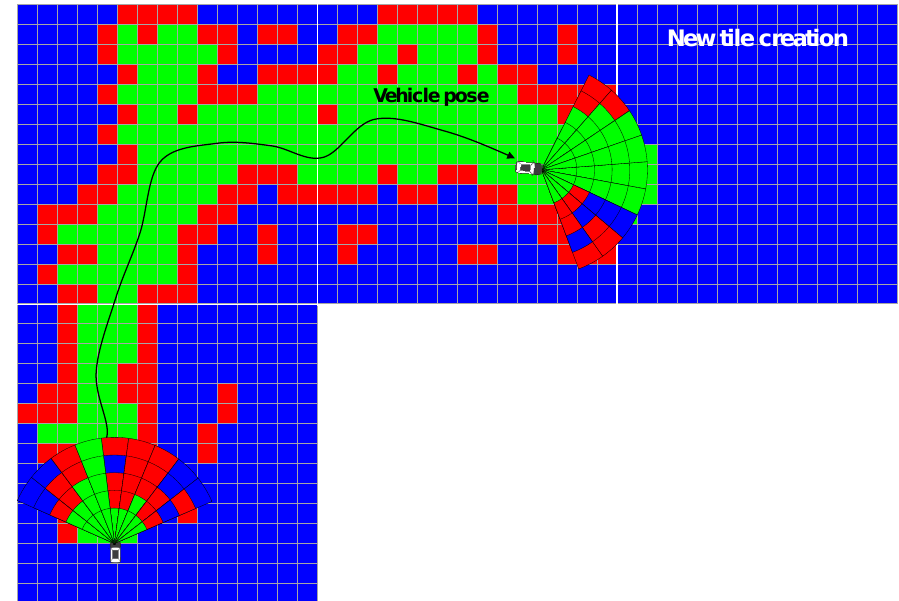
Figure 7. Mapping of Global EOGM based on the quadtree